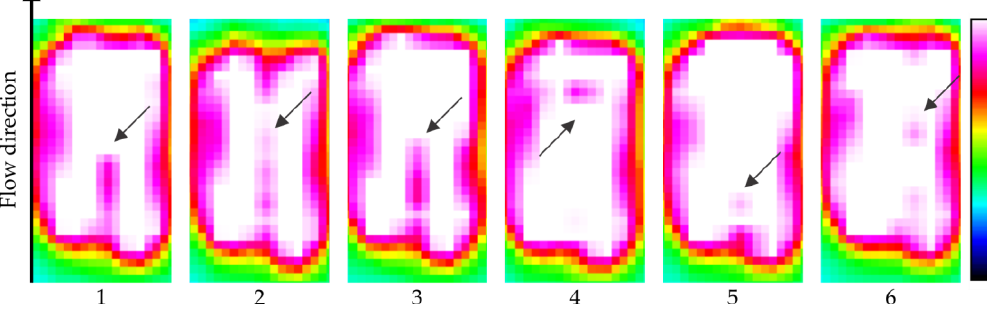
Figure 6. Frames of six different small bubbles flowing in static crude oil. The arrows show the location of the bubbles.